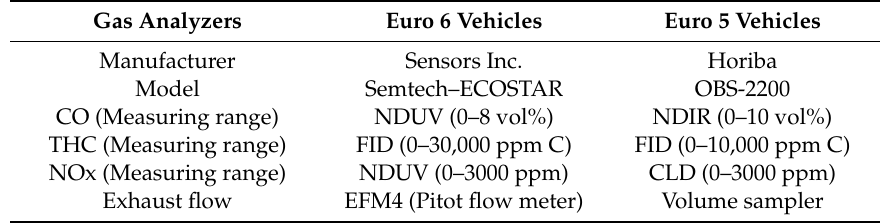
Figure 2. Schematic diagram of the experimental setup for Euro 6 heavy-duty vehicles (Euro 5 vehicles used a Horiba OBS-2200 analyzer). FID: flame ionization detector, ECU: electronic control system, FEM: fuel economy meter, GPS: global positioning system, ICM: in-vehicle control module, PDCM: power distribution and control module. Table 2. Characteristics of portable emission measurement system (PEMS) analyzers.